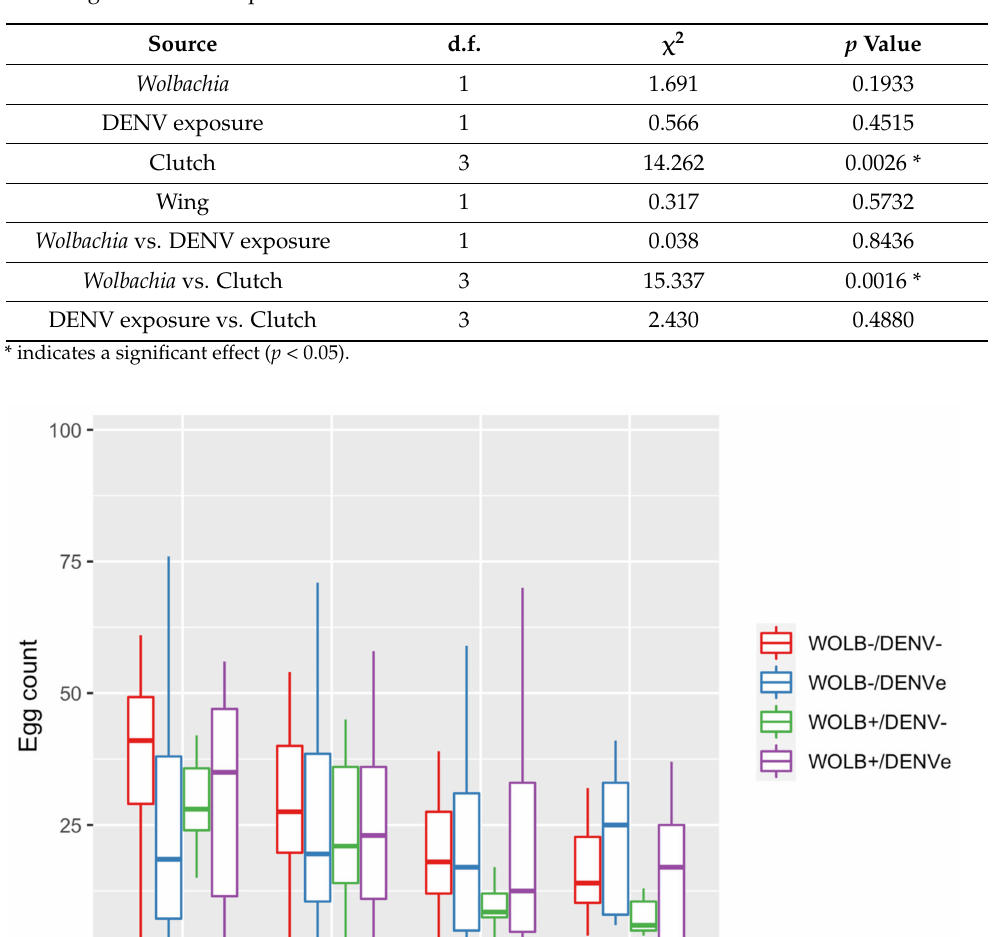
Table 1. Logistic regression analysis of the influence of Wolbachia , DENV-exposure, age at oviposition and wing size on the oviposition success.